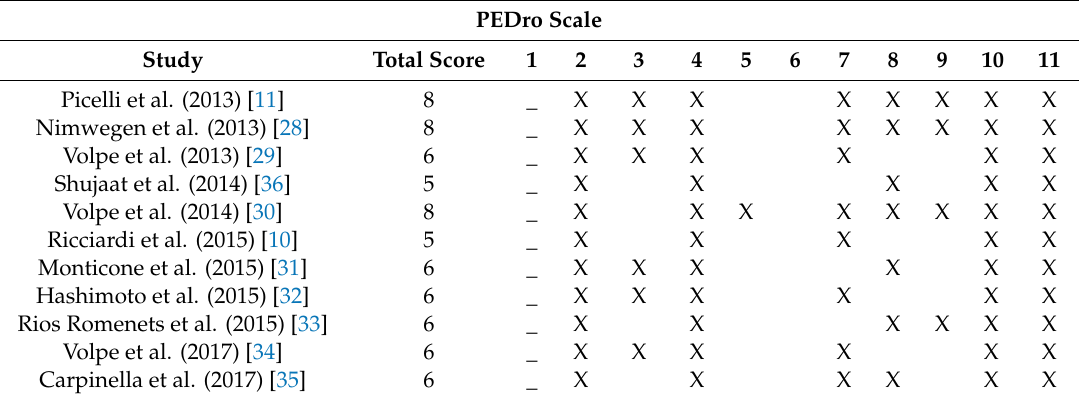
Table 2. Scores obtained after methodological evaluation according to the PEDro scale. PEDro